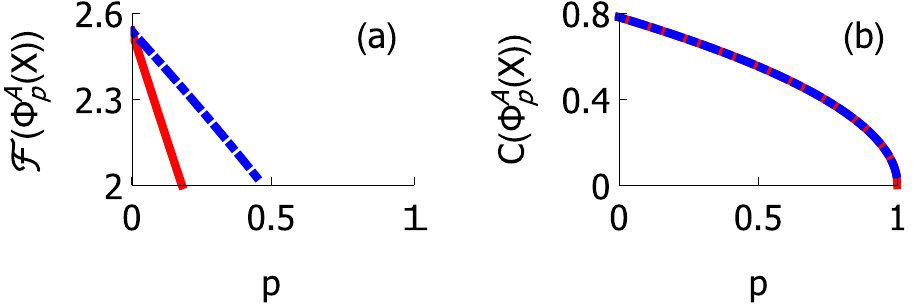
Figure 7. Behavior of ( a ) Bell function and ( b ) concurrence as a function of channel parameter p . In each plot the red and blue lines correspond to amplitude damping channel affecting qubits U and L , respectively. Here we ρ = . 0 1875, have chosen ρ ρ = = 0, and ρ = . 0 8125 . 11 44 22 33